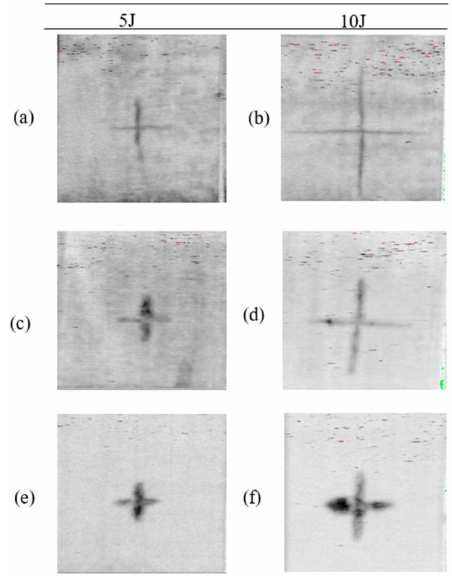
Figure 11. Damage area from CT-scanned image in composites ( a ) B-flax at 5 J, ( b ) B-flax at 10 J,